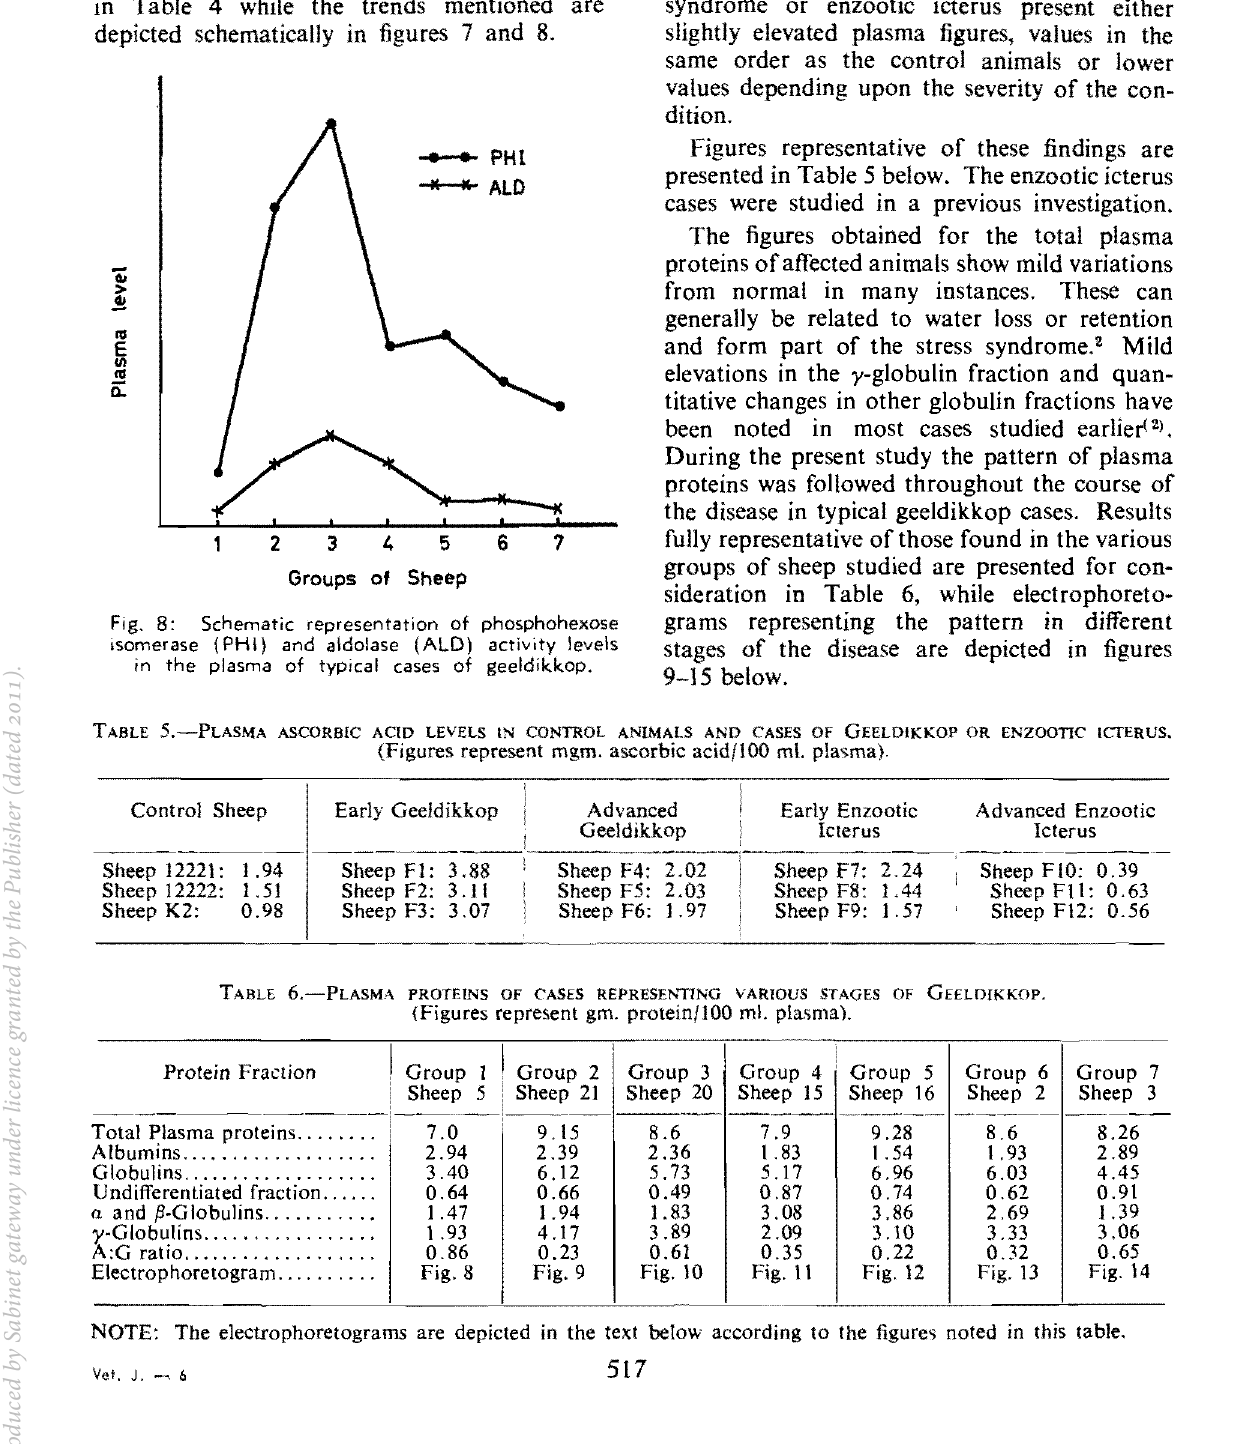
Fig. 8: Schematic representation of phosphohexose isomerase (PHI) and aldolase (ALD) activity levels in the plasma of typical cases of geeldikkop. TABLE 5.-PLASMA ASCORBIC ACID LEVELS IN CONTROL ANIMALS AND CASES OF GEELDIKKOP OR ENZOOTIC ICTERUS. (Figures represent mgm. ascorbic acid/l00 mt plasma). Control Sheep